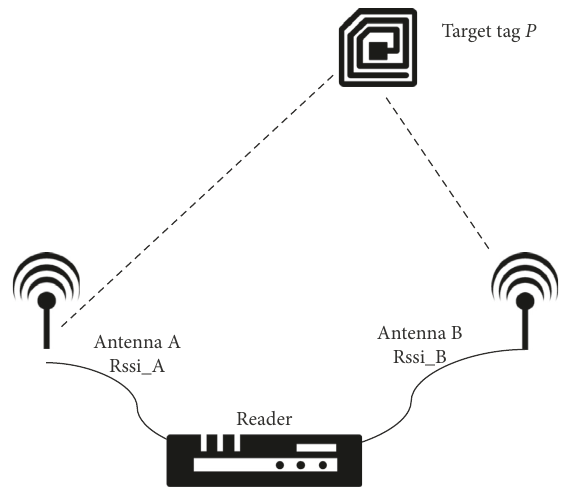
Figure 10: Scenario of RFID